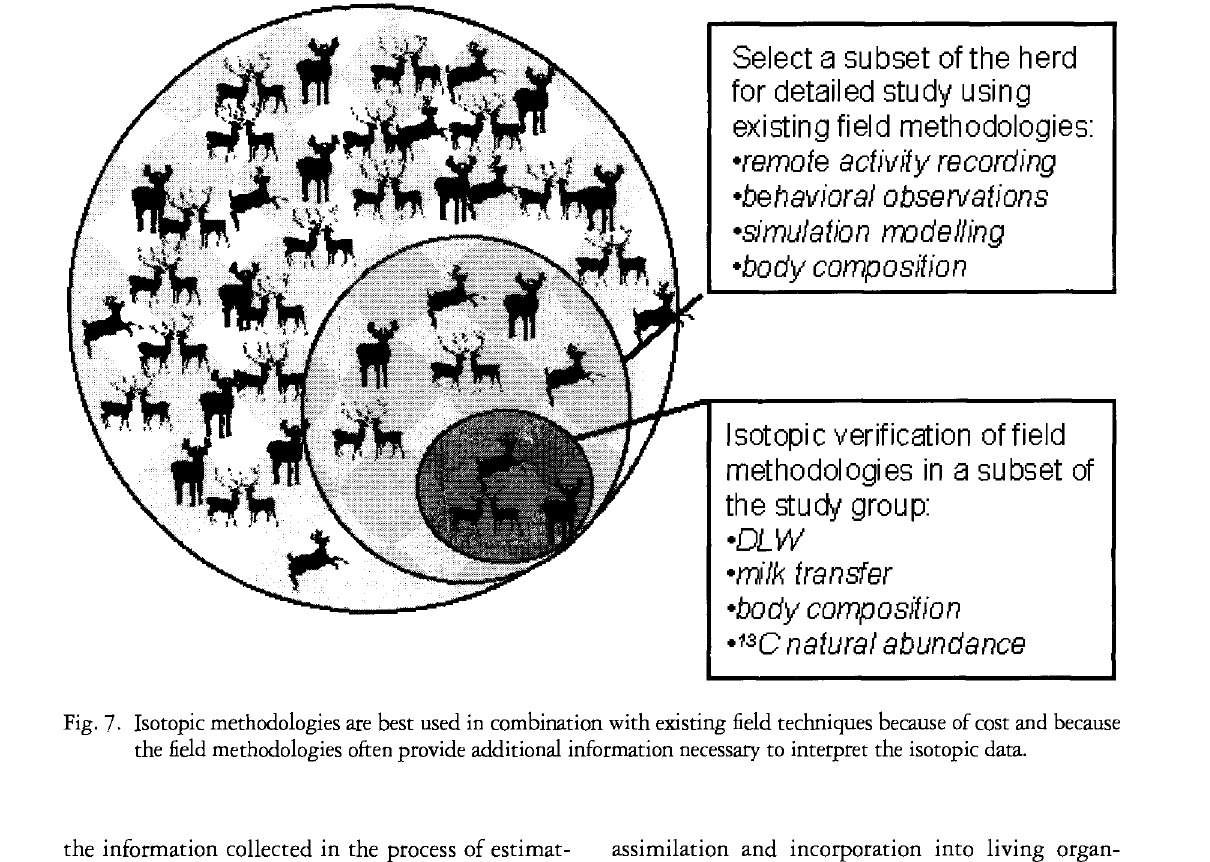
the information collected in the process of estimat ing the transfer of nutrients in milk from the moth er to the young is the same information needed